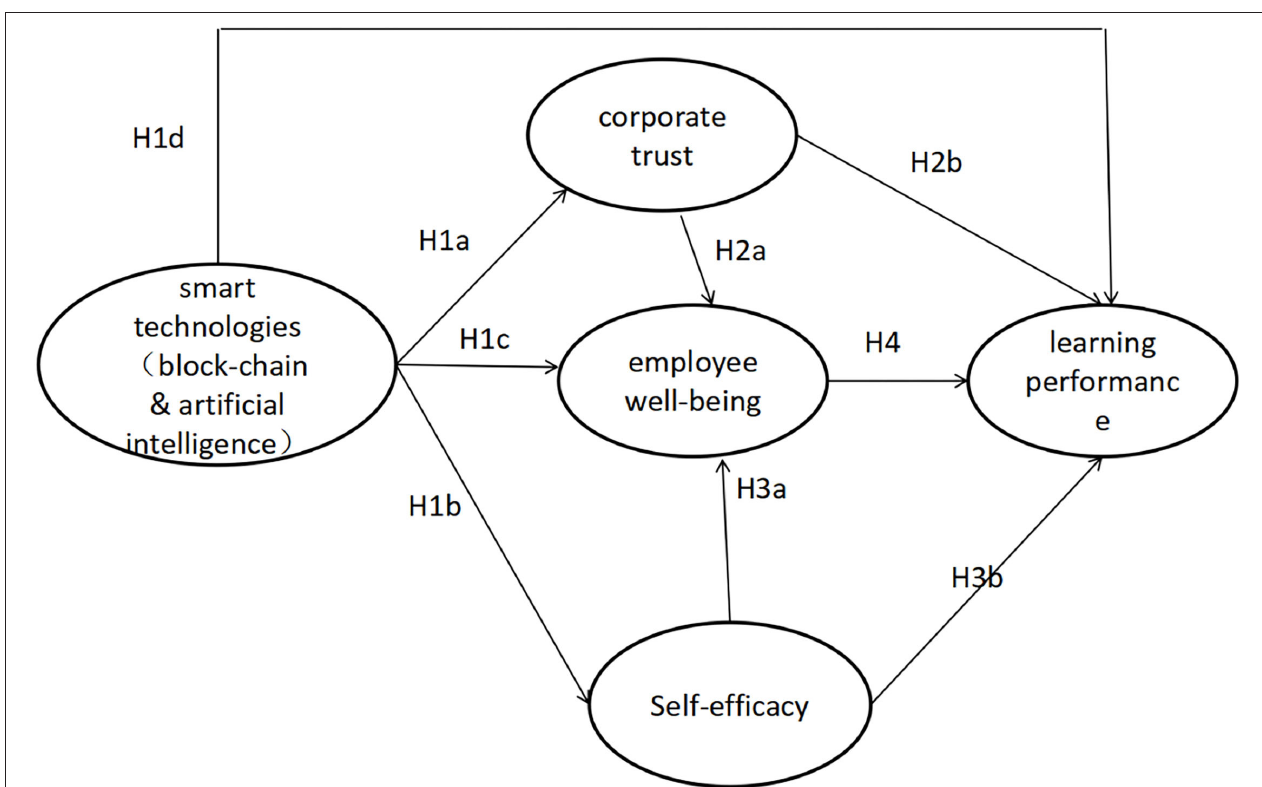
FIGURE 2 | Conceptual